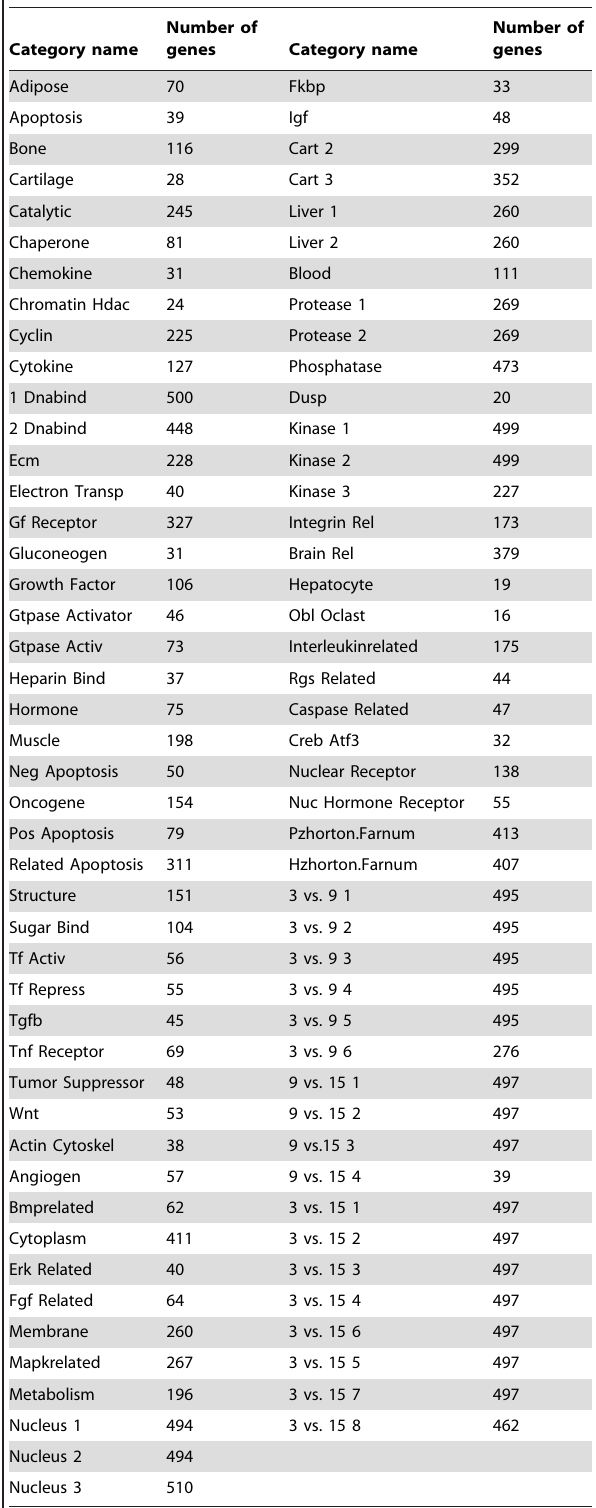
Table 3. Gene sets used in